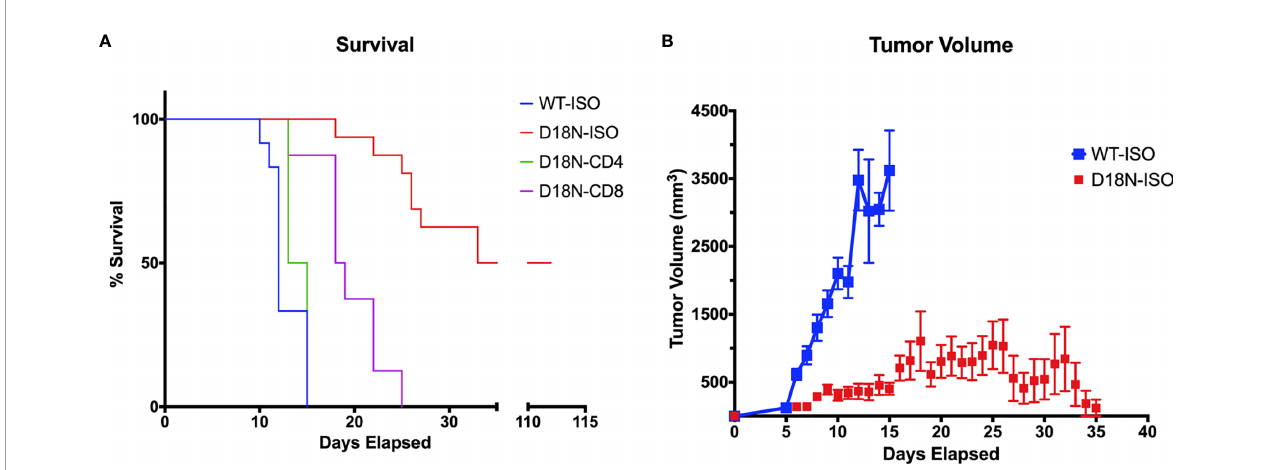
FIGURE 3 | TREX1 D18N Mice Display T-cell Dependent Antitumor Immunity. (A, B) 5x10 6 H31m1 tumor cells were injected subcutaneously into WT and D18N mice, and survival (A) and tumor volume (B) tracked daily (see Methods). Mice were treated with a CD4, a CD8, or the respective isotype-control antibodies to test the effects of T-cell depletion (see Methods). Isotype controls are presented together. Tumor volumes are average and standard deviation. Background of mice and tumor cells was 129S1/SvImJ, and each group represents 8-16 mice across 2-4 independent experiments. Data originally submitted for ASBMB 2020 conference (93). Graphs generated with Prism 7.0